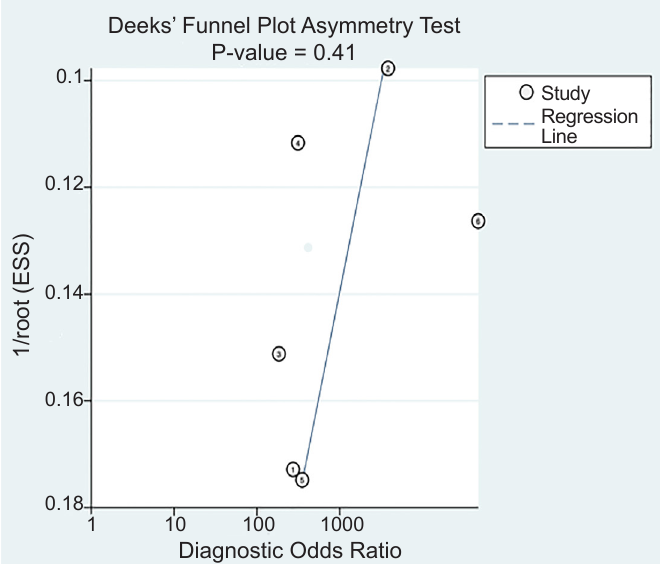
Figure 4. Funnel plot with all included studies. 1=Lam, 2=Muniz, 3=Riera, 4=Trigylidas, 5=Zerzan, 6=Lin. ESS, effective sample size.